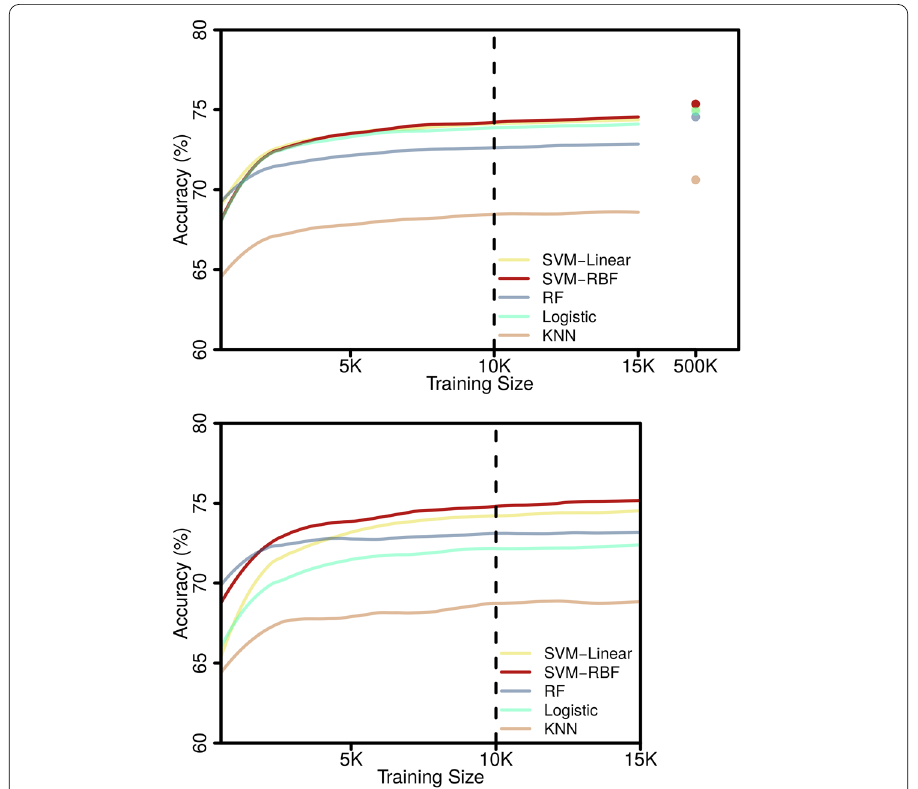
Figure 2 Accuracy in EU (top) and SA (bottom) as a function of the size of the training sample . We reach an accuracy beyond 74% with training sets of 10k people. In case of data scarcity, we can further reduce the training size to 5k with minimal deterioration in performance. SVM-RBF reaches a higher accuracy than other algorithms in both cases for training sets larger than 5k people. In EU, increasing the training set size from 15k to 500k only increases the best accuracy by 1%.